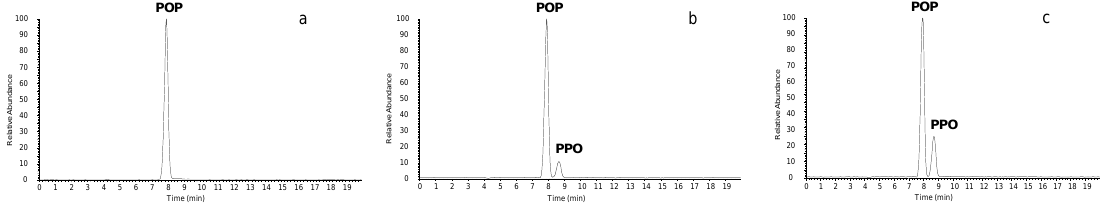
Figure 4. LC-MS (Liquid chromatography-mass spectrometry) chromatograms of cocoa butter samples pre deodorization ( a ) and deodorized at two different temperatures 220 °C ( b ) and 260 °C ( c ), corresponding to the absence and to the presence of thermally formed positional isomers, respectively.